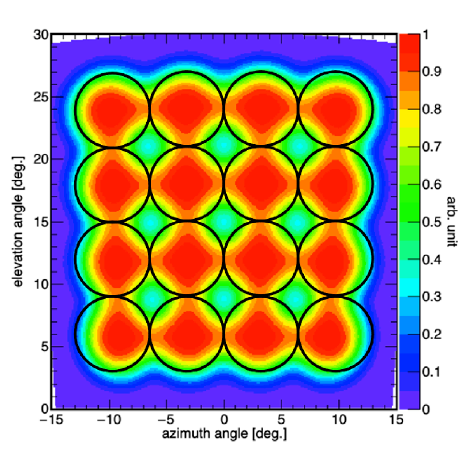
Figure 9. Sensitivity map as a function of arrival direction of in- cident light at the focal plane with 16 PMTs with 5 in. diameter. The arrangement of PMTs of new configuration is four by four